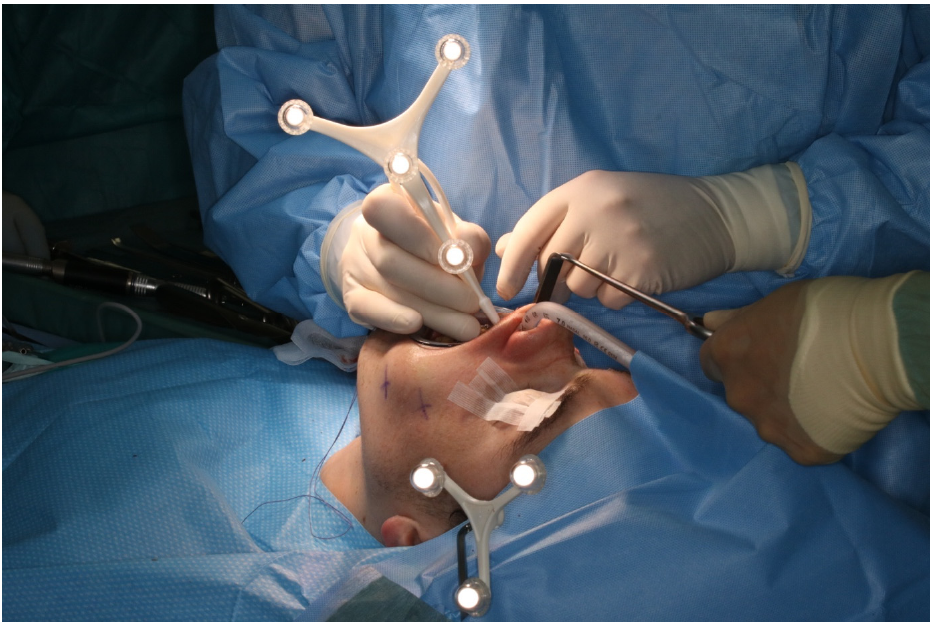
Figure 7. Intraoperative surface registration of at least four different anatomical landmarks with the DRF attached to the Mayfield clamp.